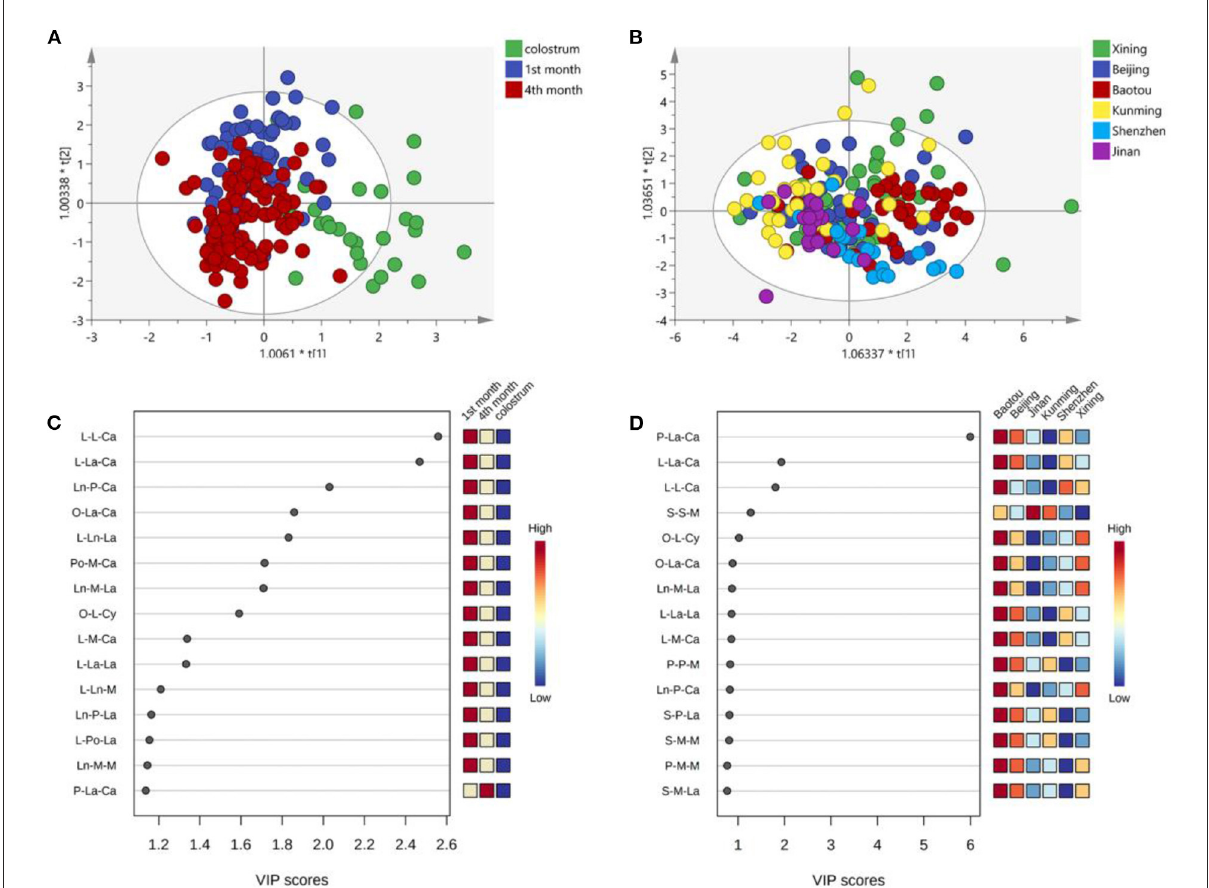
FIGURE3 OPLS-DA analysis of MLCT types TAG across the lactation stage (A) and cities (B) ; VIP scores plot for cluster analysis of MLCT molecules across the lactation stage (C) and cities (D) .